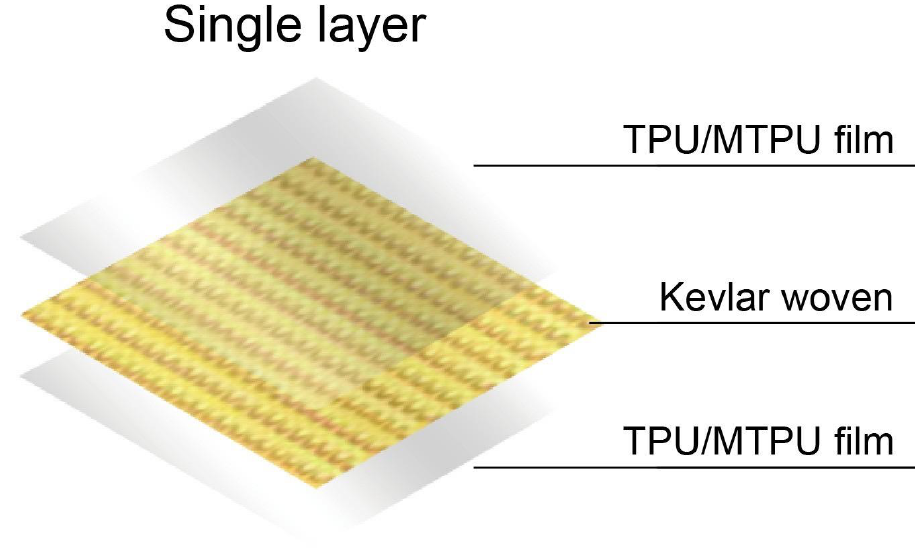
Figure 2. Illustrative diagram of the structure of a single TPU film.